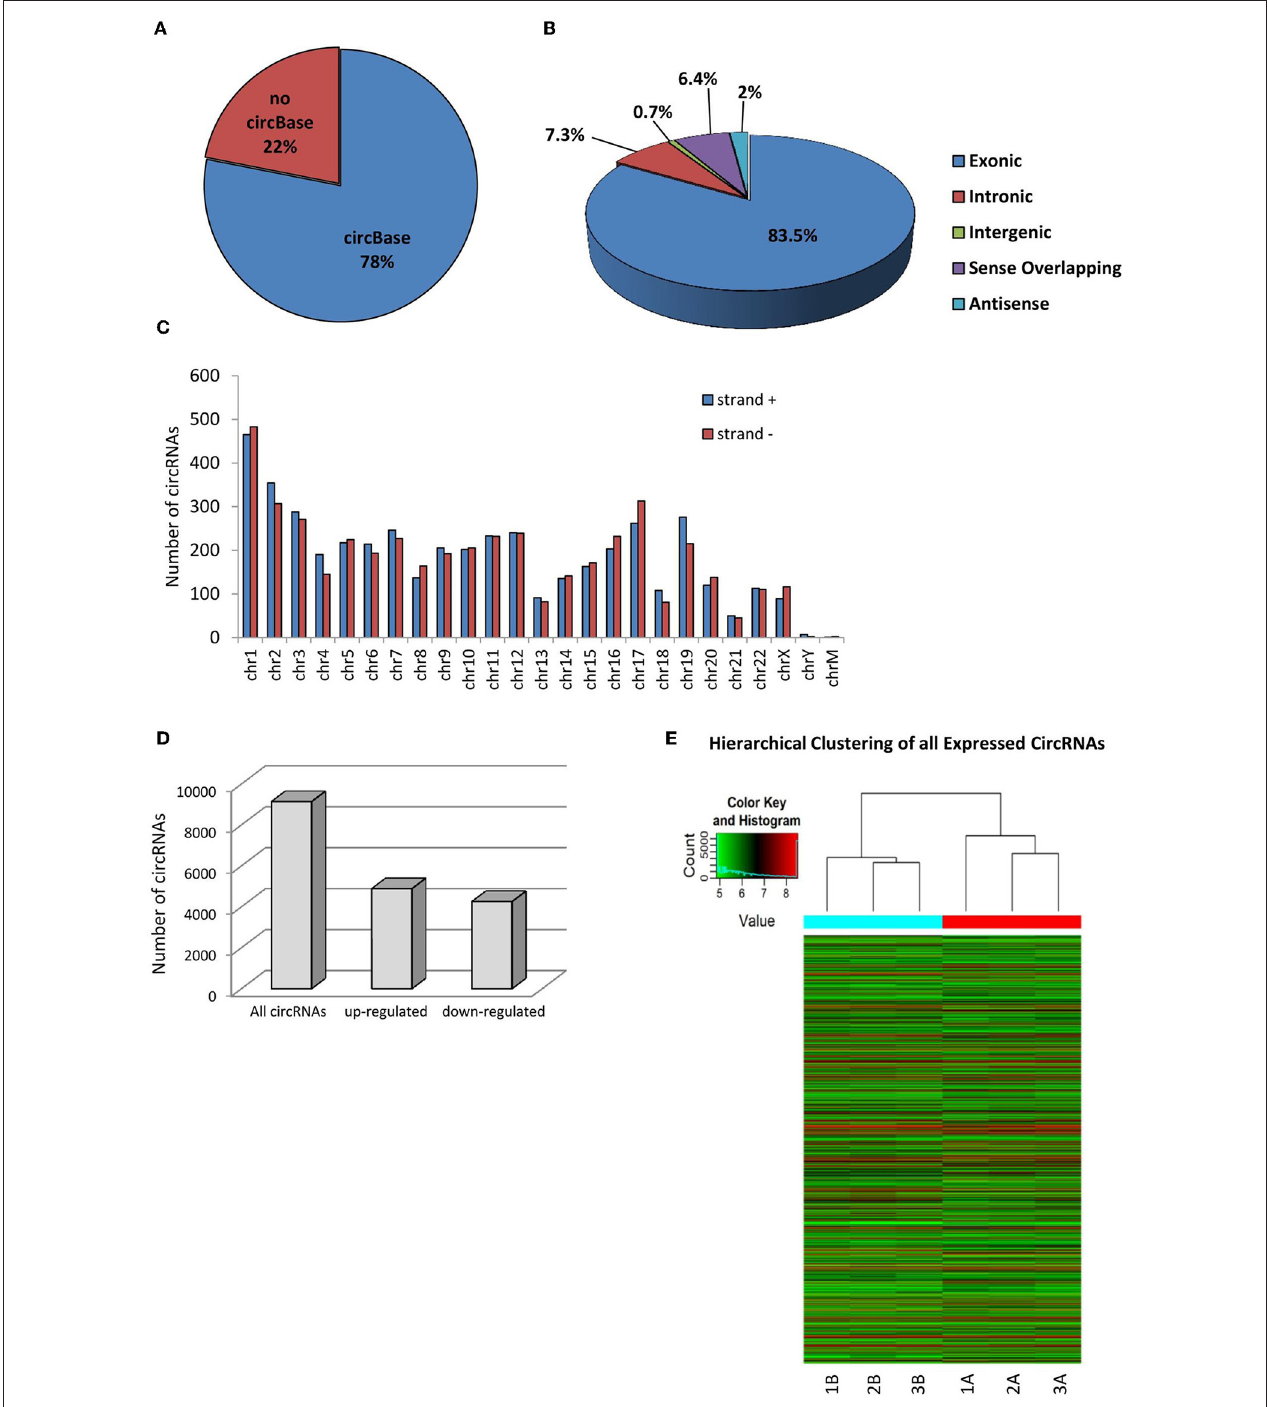
FIGURE 1 | Overview of circRNA expression in asthenozoospermic derived SPZ. (A) The proportion of circRNAs from circBASE (http://circbase.mdc-berlin.de) and other databases/literature on a total of 9,138 circRNAs identified. (B) The proportion of different types of circRNAs among all predicted circRNAs. (C) Chromosomal distribution of SPZ derived circRNAs, on strand + and strand –. (D) The distribution of up- and down-regulated circRNAs in fraction B compared to fraction A asthenozoospermic derived SPZ among all circRNAs. (E) Hierarchical clustering analysis of total circRNAs samples arranged into two groups, based on their expression levels; in detail, this analysis used different colors to represent the expression values of circRNAs detected in fraction A ( n = 3, indicated as 1A, 2A, 3A) and B ( n = 3, indicated as 1B, 21B, 3B) SPZ of asthenozoospermic patients.